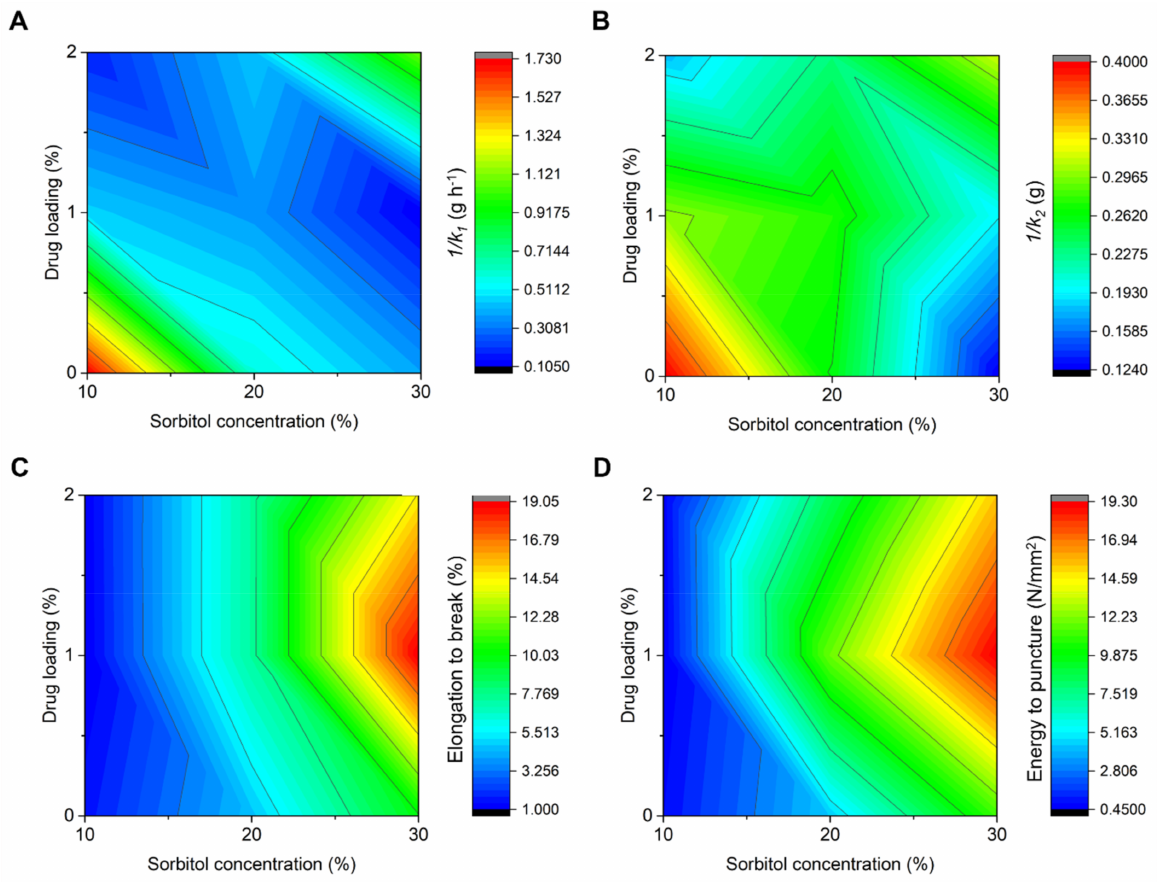
Figure 5. Comparisons of ( A , B ) inversed Peleg parameters (1/ k 1 and 1/ k 2 ), ( C ) elongation to break and ( D ) energy to puncture of rice starch